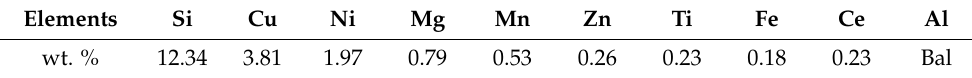
Table 1. Composition of cast Al-Si-Cu-Ni-Mg alloy.